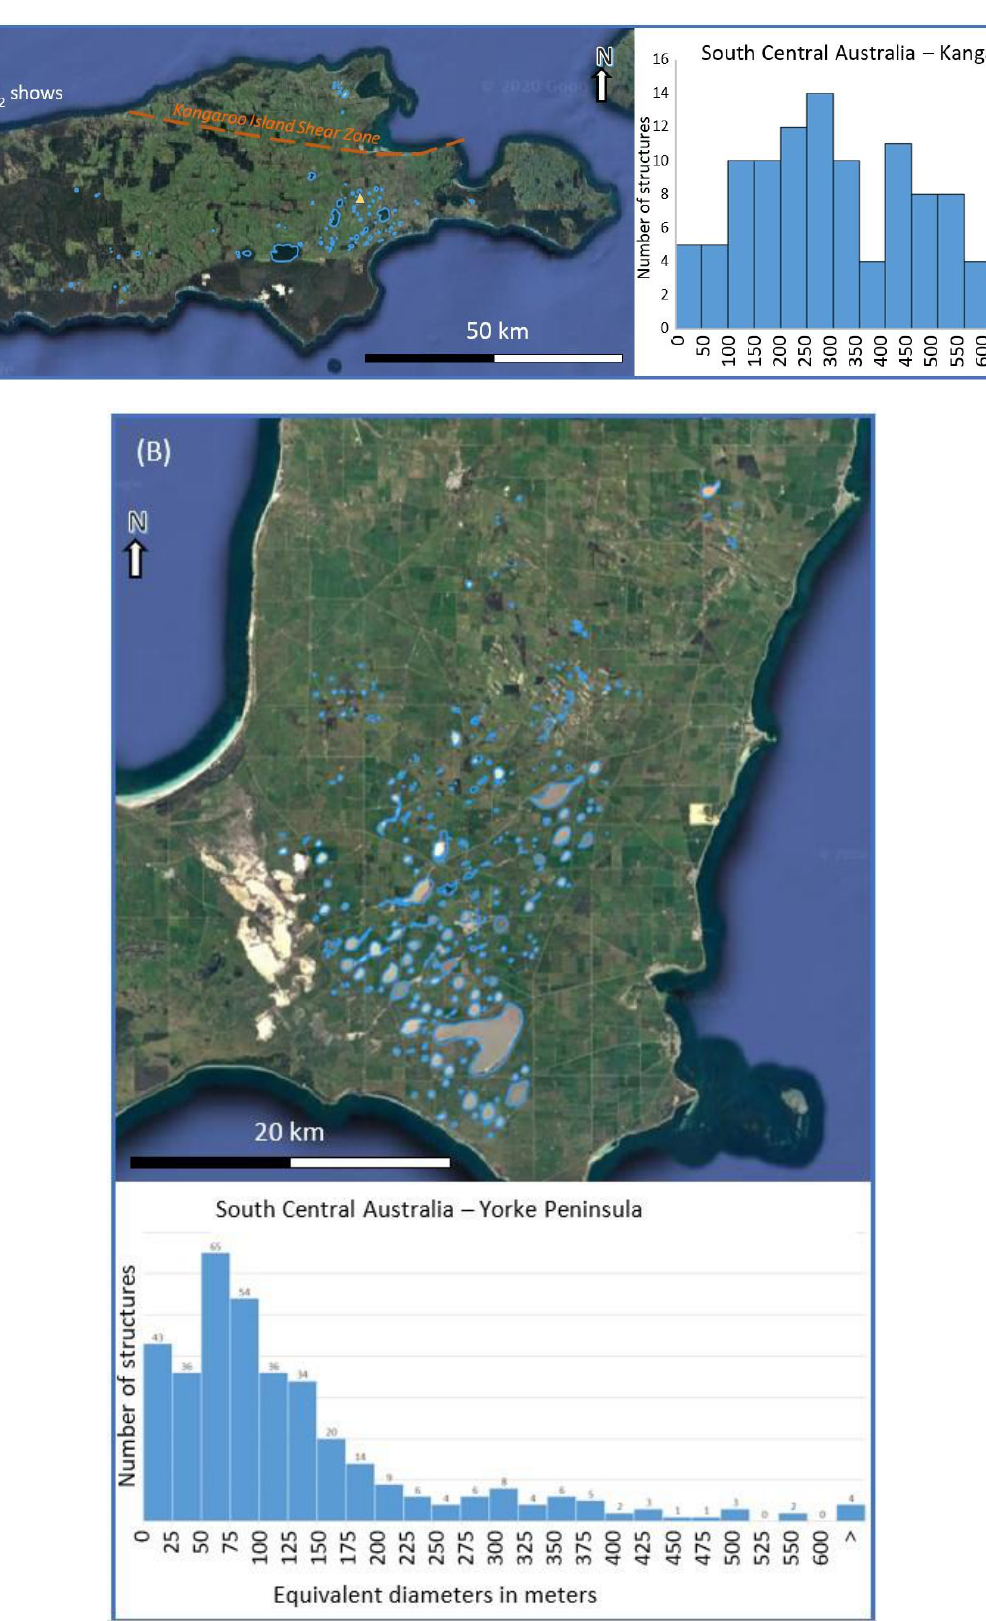
Figure 6. The mapping and the diameter equivalent statistic for the fairy circles in the Adelaide Area, South Australia. ( A ) ( above ) Kangaroo Island, ( B ) ( below ) Yorke Peninsula.